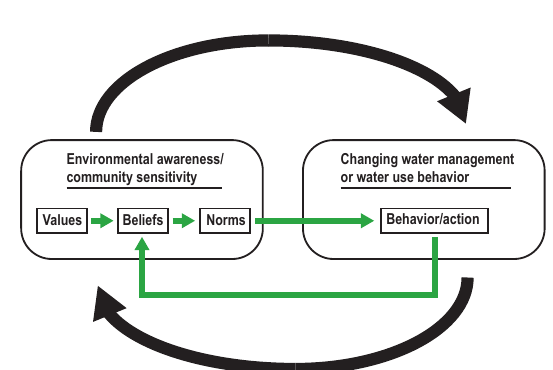
Figure 6. A conceptual diagram of relationships between variables studied in SH modeling and VBN theory. Black arrows show the feedback loops captured in SH modeling and green arrows show relationships that need to be studied in the context of water man-